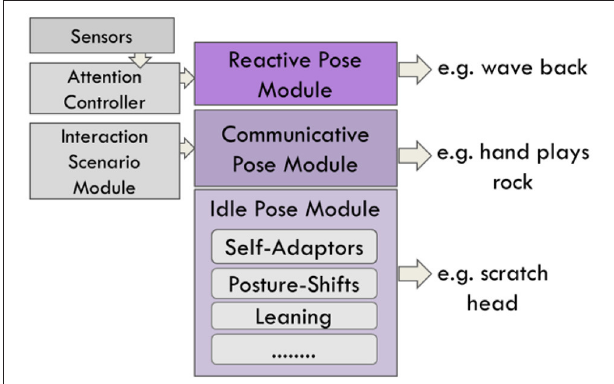
FIGURE 5 | Structure of the gesture and post controller. Three types of gestures and pose behaviour are generated: Reactive, communicative and